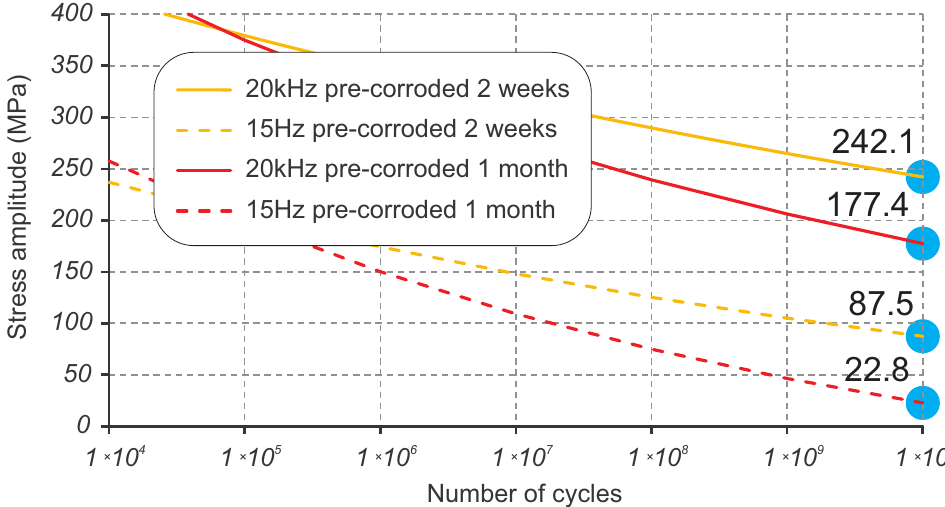
Figure 10. Extrapolation of the pre-corroded SN curves to 10 billion cycles and scaling down to low